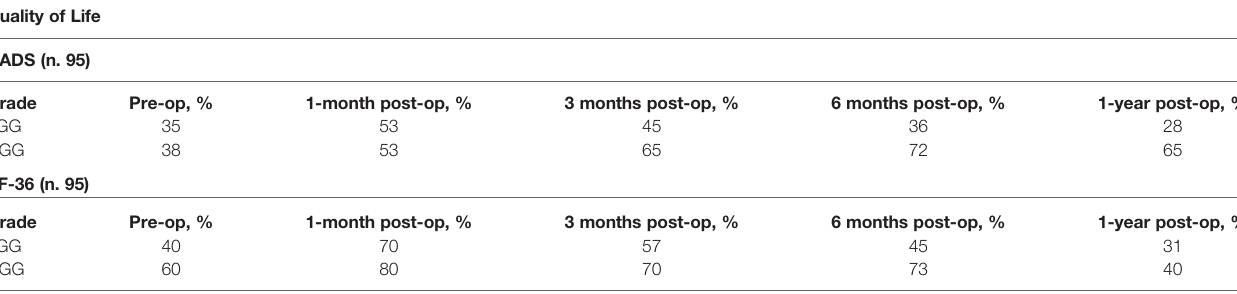
TABLE 3 | Quality of Life